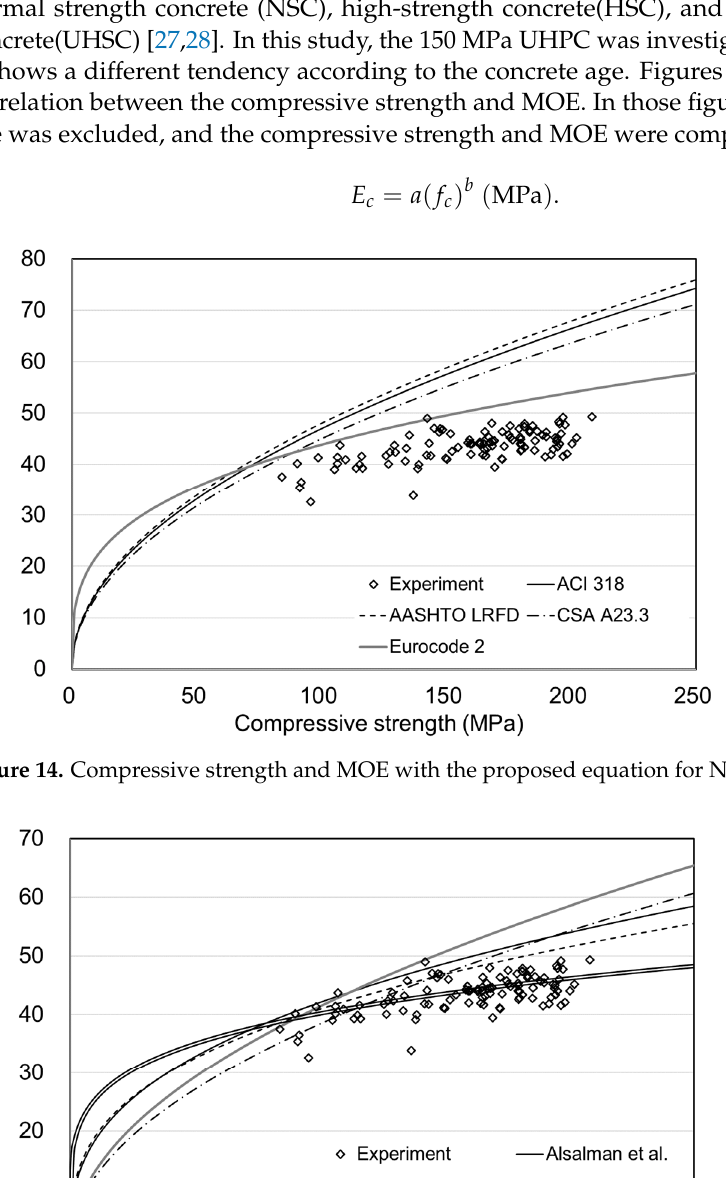
Figure 13. Elastic modulus of steam curing.